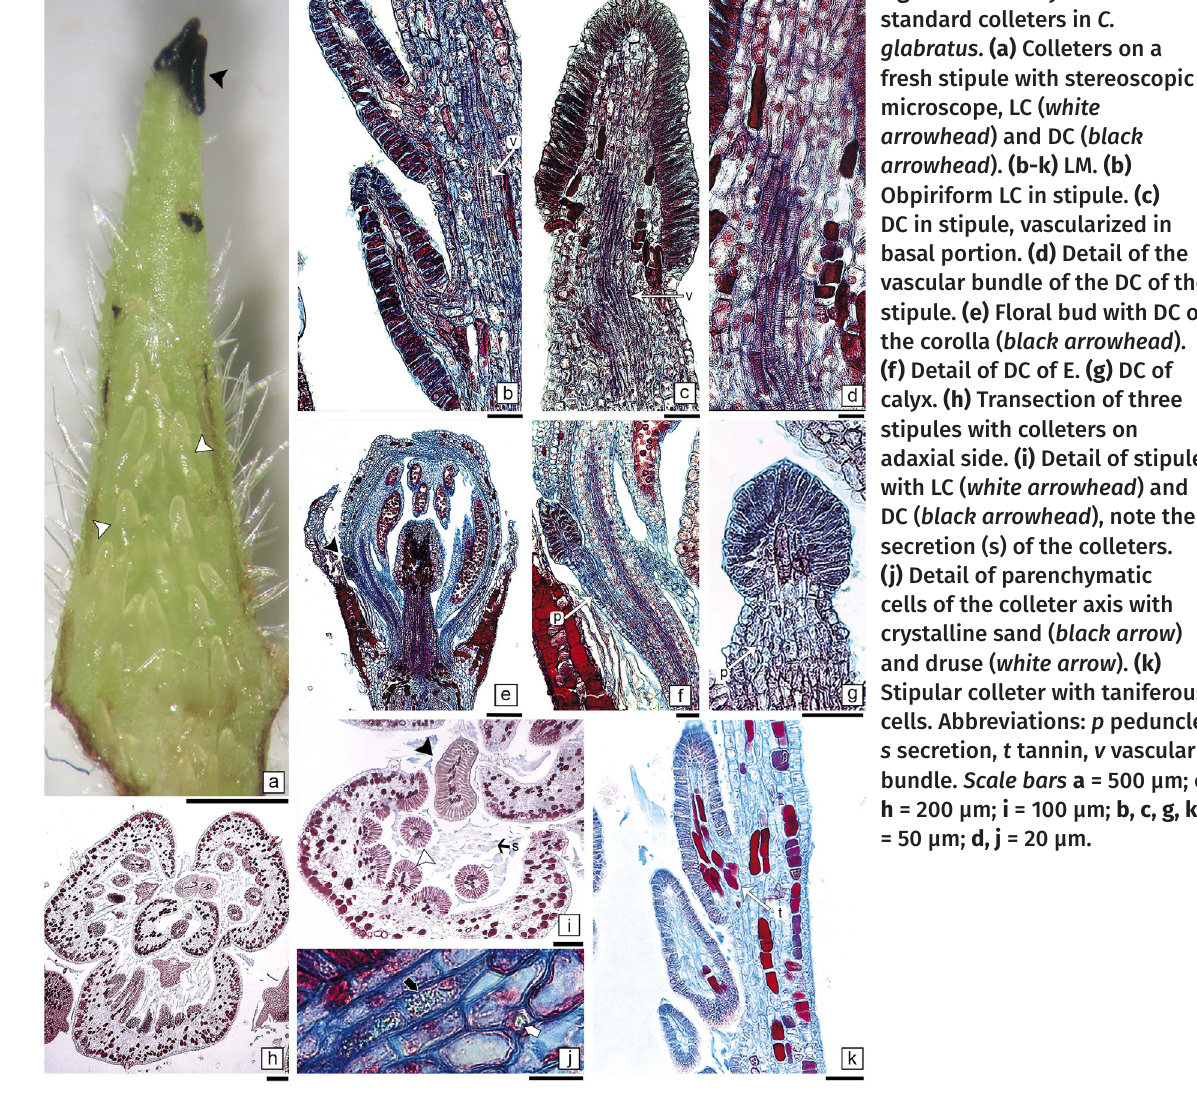
Figure 1. Anatomy of the standard colleters in C. glabratus . (a) Colleters on a fresh stipule with stereoscopic microscope, LC ( white arrowhead ) and DC ( black arrowhead ). (b-k) LM. (b) Obpiriform LC in stipule. (c) DC in stipule, vascularized in basal portion. (d) Detail of the vascular bundle of the DC of the stipule. (e) Floral bud with DC on the corolla ( black arrowhead ). (f) Detail of DC of E. (g) DC of calyx. (h) Transection of three stipules with colleters on adaxial side. (i) Detail of stipule with LC ( white arrowhead ) and DC ( black arrowhead ), note the secretion (s) of the colleters. (j) Detail of parenchymatic cells of the colleter axis with crystalline sand ( black arrow ) and druse ( white arrow ). (k) Stipular colleter with taniferous cells. Abbreviations: p peduncle, s secretion, t tannin, v vascular bundle. Scale bars a = 500 µm; e, h = 200 µm; i = 100 µm; b, c, g, k = 50 µm; d, j = 20